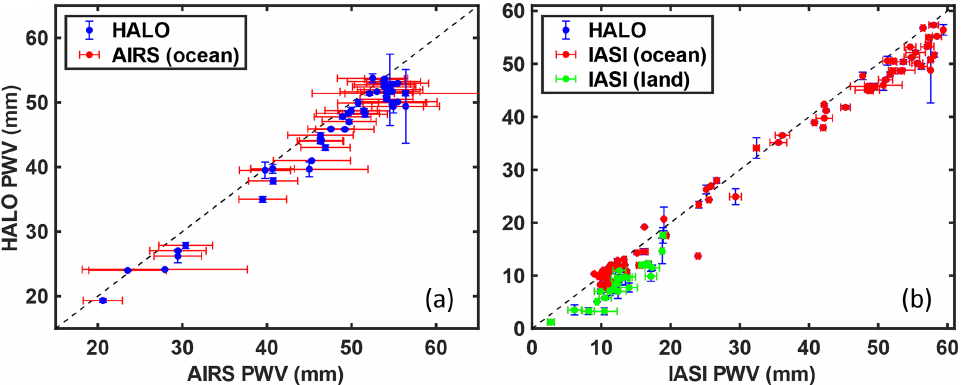
Figure 11. Comparison of (a) AIRS or (b) IASI PWV with the average HALO PWV calculated within each satellite retrieval footprint. Bars for AIRS are the reported retrieval uncertainties. Bars for HALO and IASI are standard deviations. Dashed line is 1 : 1, for